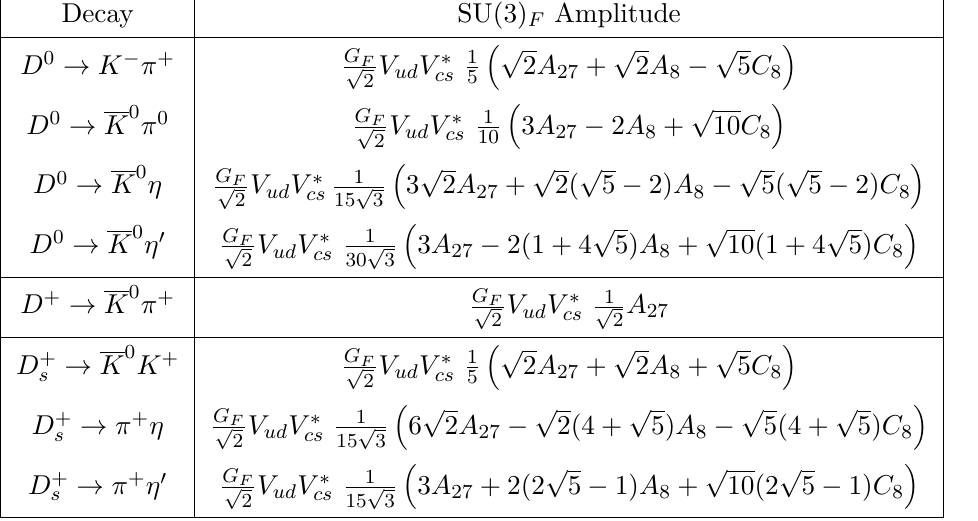
Table 2. SU(3) F matrix-elements representation of Cabibbo-Favored Decays in the Standard Model. Note that the η − η 0 angle θ = arcsin(1 / 3) .